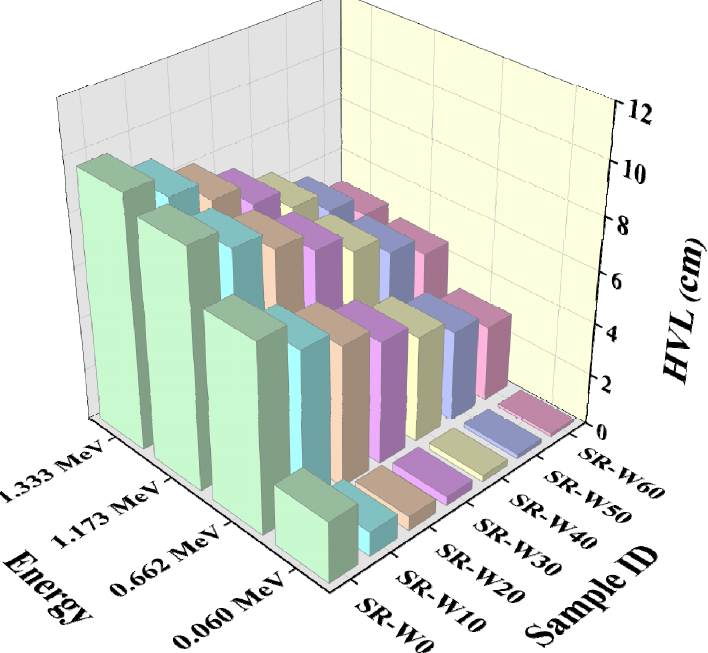
Figure 10. Pictorial presentation of the MAC of prepared silicone rubber (SR-W) systems with the function of energy.